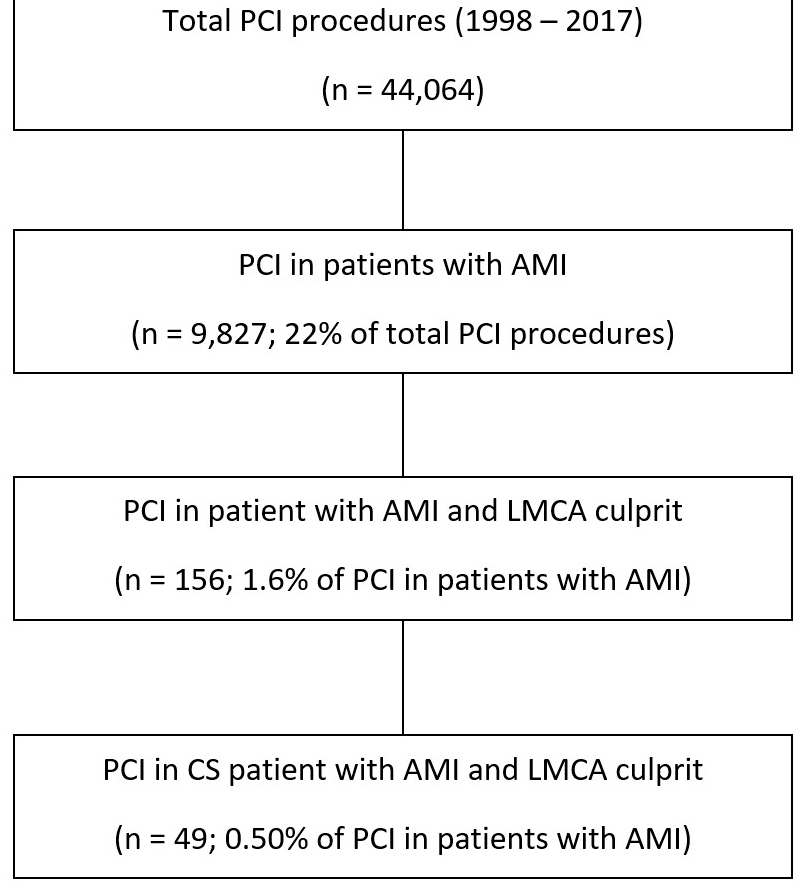
Figure 1. Study flow chart.